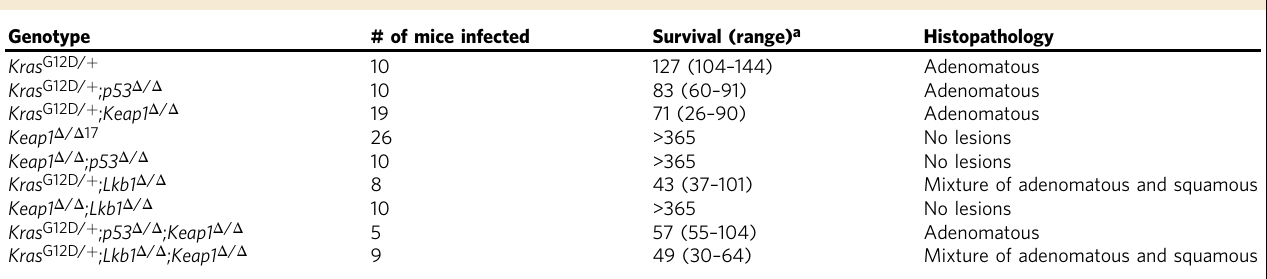
Table 1 Comparison of murine lung cancer model cohorts Genotype # of mice